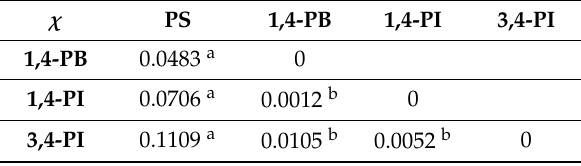
Table 3. Flory–Huggins interaction parameters for all block